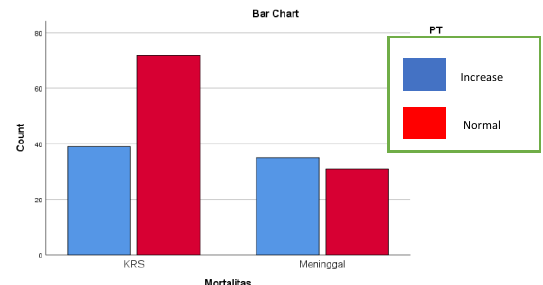
Figure 4. Diagram of the Relationship between Elevated of Transaminase and